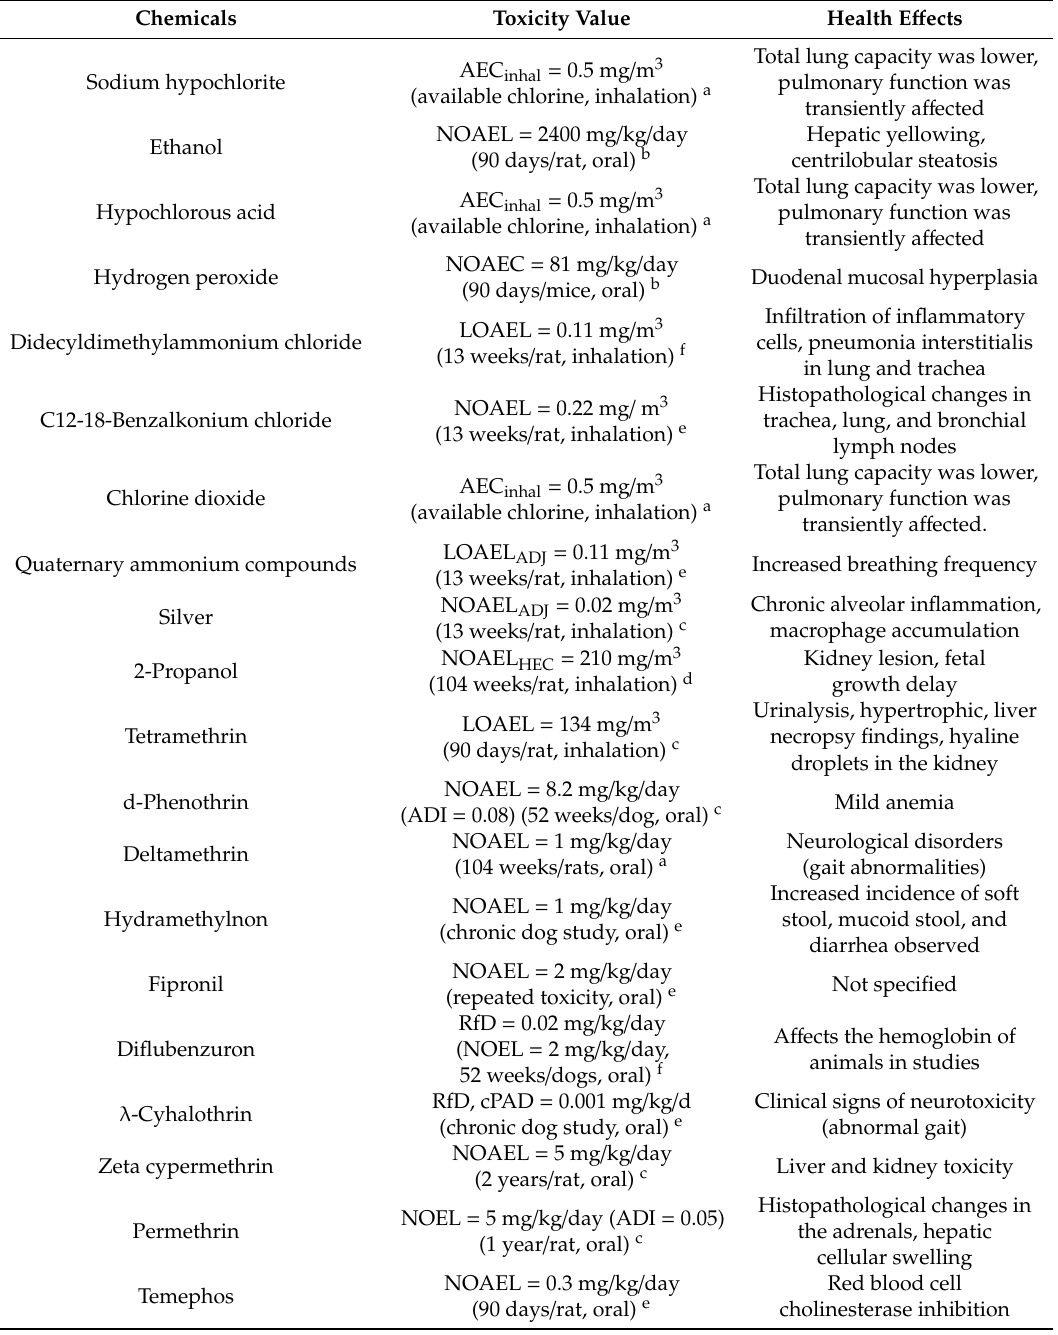
Table 7. Summary of toxicological endpoint for ingredients in biocidal